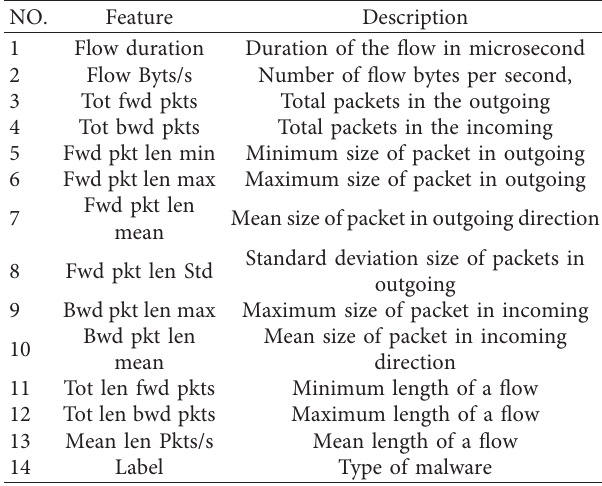
Table 6: Features that are most representative of the network traffic of malware and benign for logistic